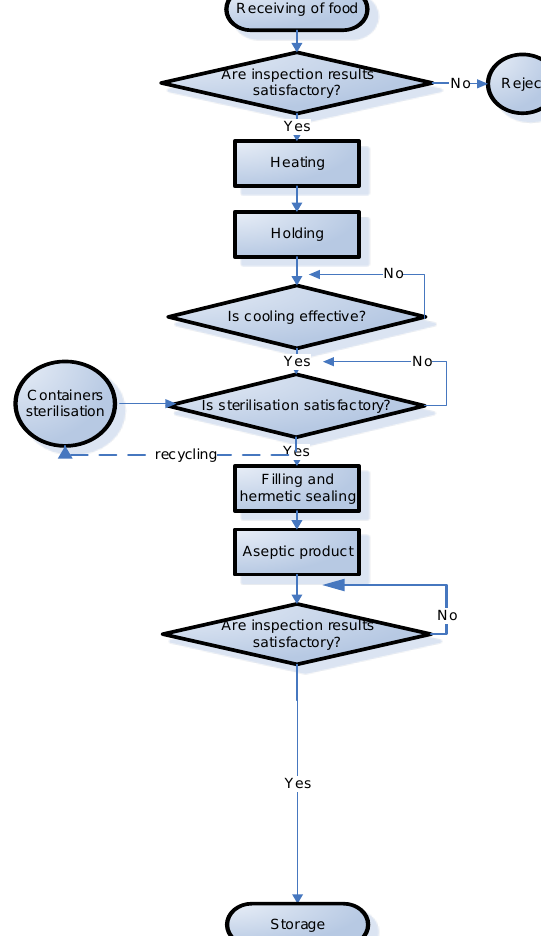
Figure 2. Flow diagram of aseptic processing.